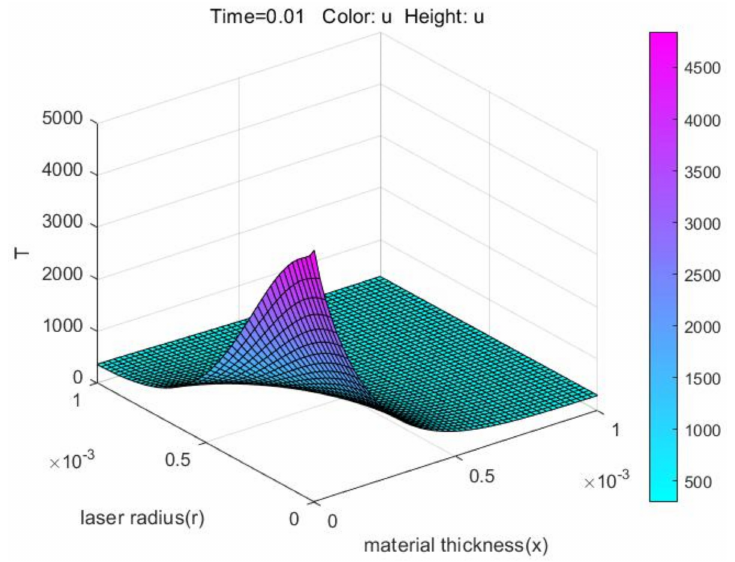
Figure 12. Numerical solutions obtained by PDETOOL of